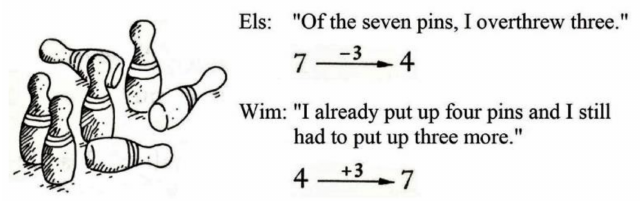
Figure 2. Arrow language in Wiskobas [39] (p.